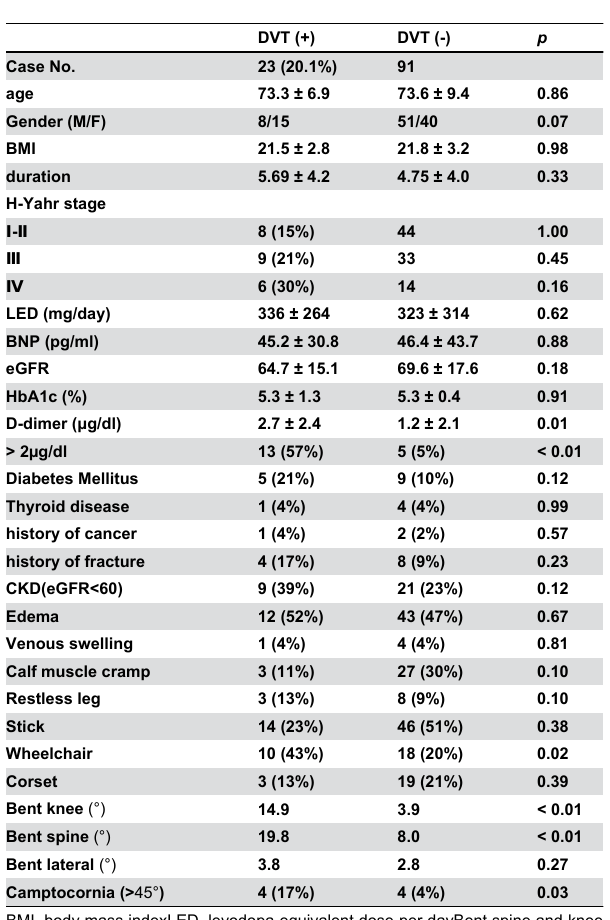
Table 1. (a) Overall clinical findings in the DVT-positive and -negative PD patient